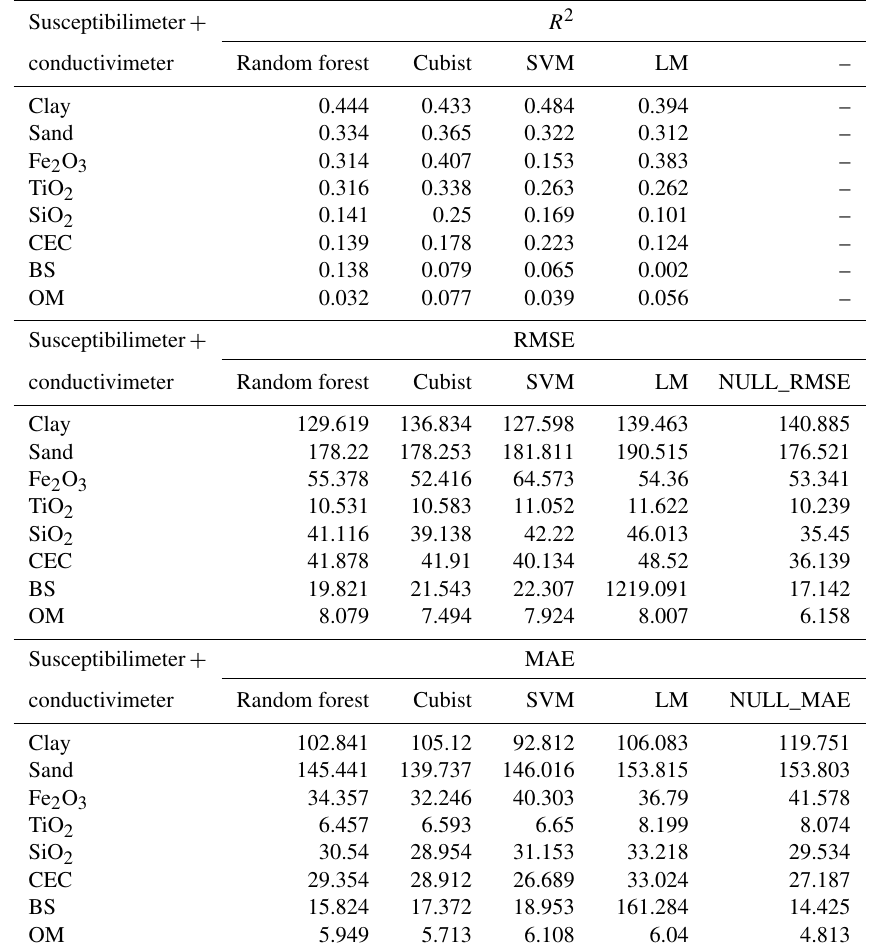
Table 3. Model performance for the combined use of susceptibilimeter and the conductivimeter, for all soil attributes, based on R 2 , RMSE, MAE, and